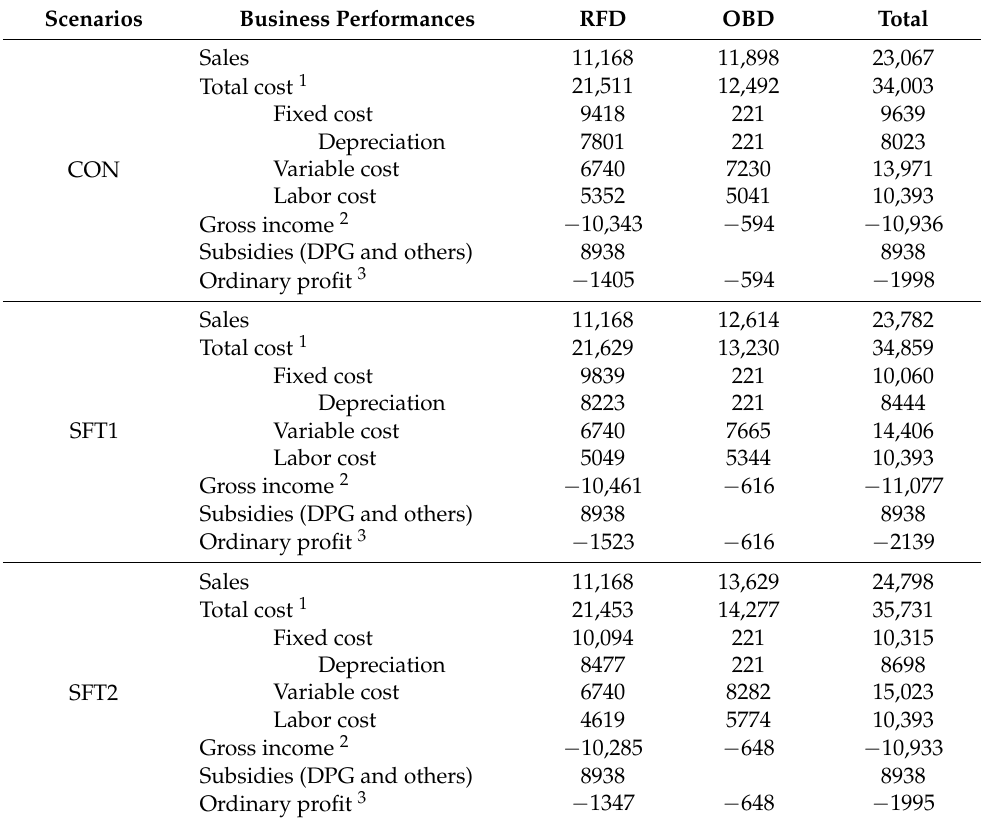
Table 3. Simulated business performance of three scenarios (1000 yen).